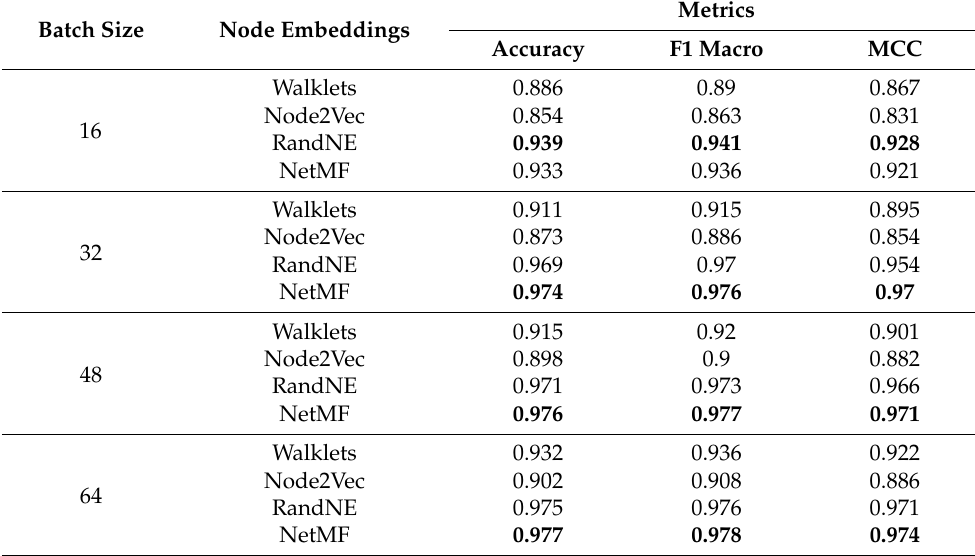
Table 2. Two-factor performance comparison on predicting experimental task, taking into account the influence of node embedding methods and batch sizes for the task fMRI classification. The training processes were set with 100 epochs, 10 step patience for early stopping, and learning rate = 0.001 for Adam. The proposed GCN model showed impressive results with both RandNE and NetMF node embedding methods. Classification performance values for 302 participants’ task fMRI data were in the range of 94% to 98%. Bold values represent the best classification performance obtained for each batch